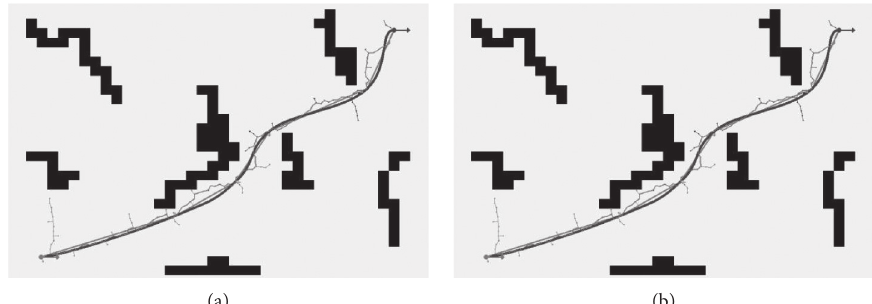
Figure 13: The basic and improved Bi-RRT algorithm in complex environment. (a) The basic Bi-RRT method. (b) The improved Bi-RRT method.